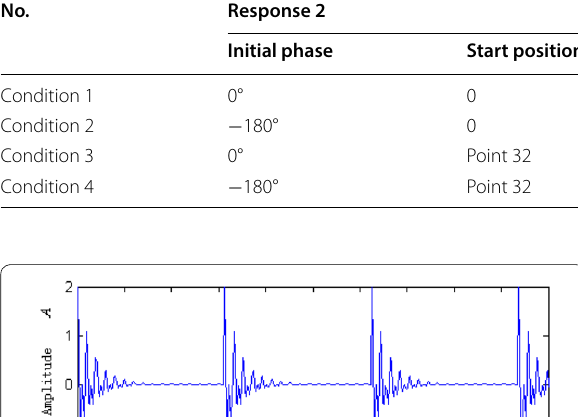
Figure 11 Superposition result under condition 3: ( a ) time